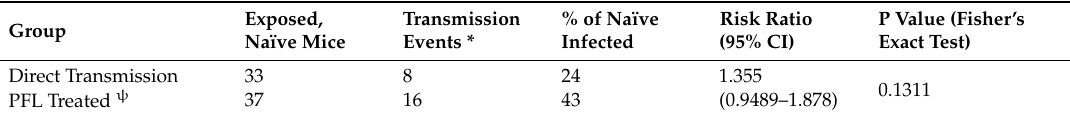
Table 2. Transmission of SNV among untreated and heat shock-induced, infected deer mice. Group